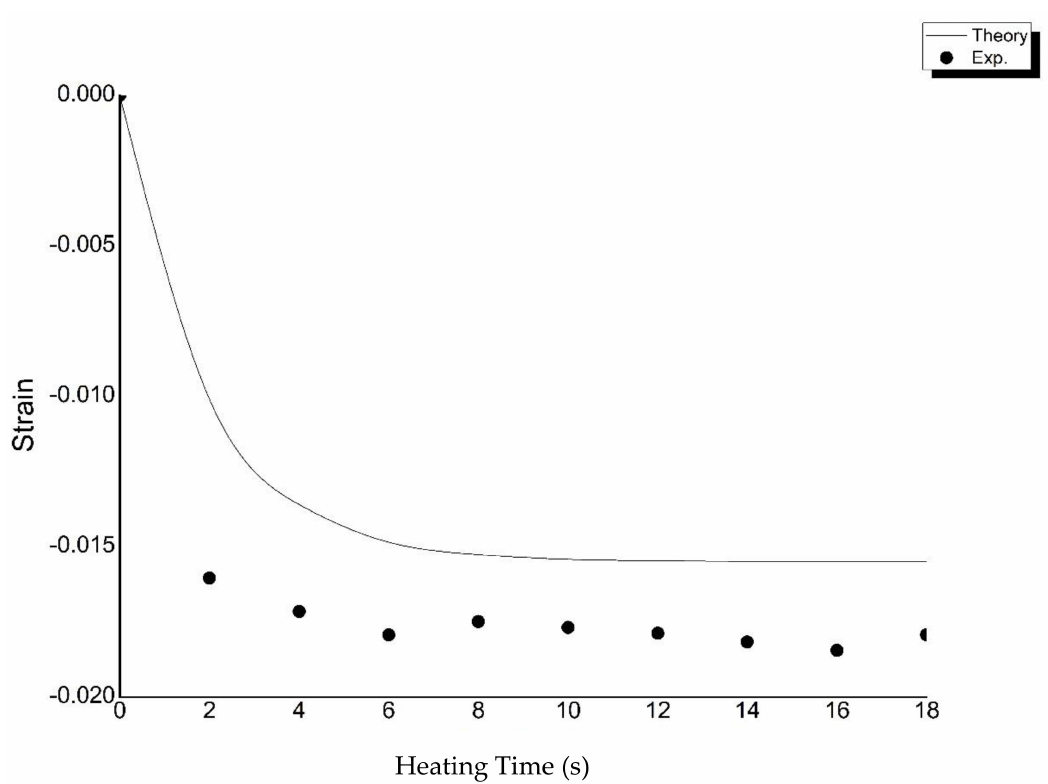
Figure 3. Theoretical and experiment data on the strain-heat time for the printed polylactic acid (PLA)